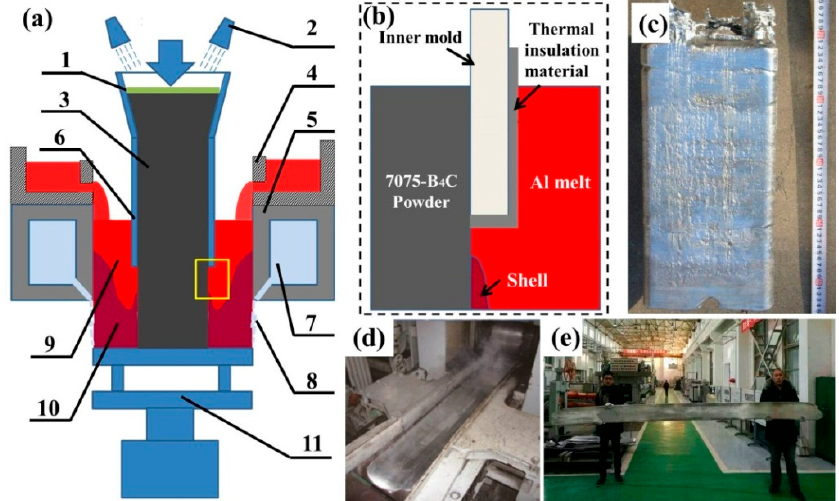
Figure 2. The schematic diagram of ( a ) the semi-continuous casting equipment, with (1) pressing plate, (2) Ar gas shield, (3) powder mixture, (4) runners, (5) outer mold (crystallizer), (6) inner mold, (7) circulating cooling water, (8) second cooling water, (9) Al melt, (10) Al shell, and (11) drawing drive; ( b ) a detail of interfacial combination between layers near the inner mold; ( c ) ingot obtained by continuous casting; ( d ) the boron carbide-reinforced aluminum layered composite (BRALC) plate with a thickness of 20 mm at the final step during hot rolling; and ( e ) the thinnest BRALC plate (3 mm) after further rolling.